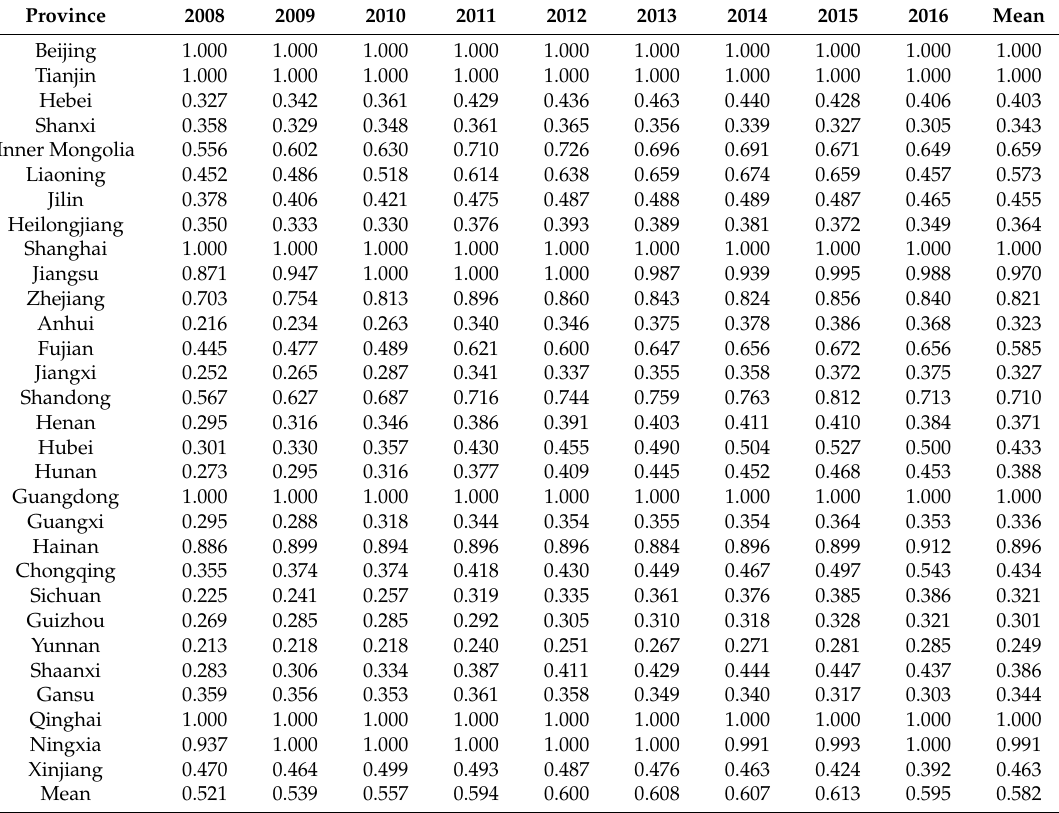
Table 4. Water use efficiency of 30 provinces of China during